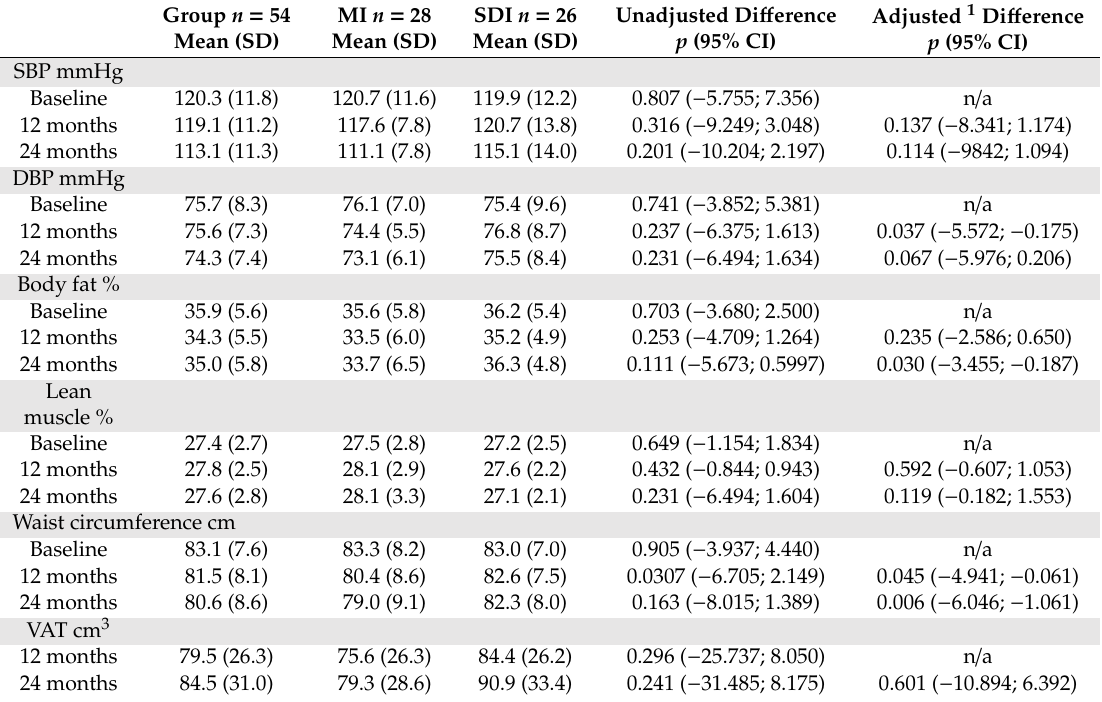
Table 3. Measures of metabolic syndrome according to intervention type (ITT analysis) ( n = 54).